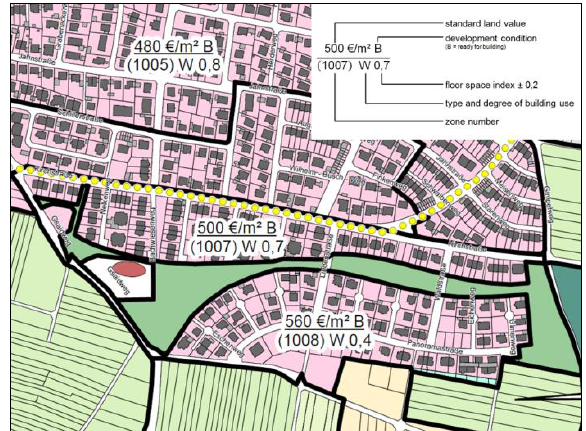
Figure 1: Standard land value zones with labels showing the values-relevant attributes